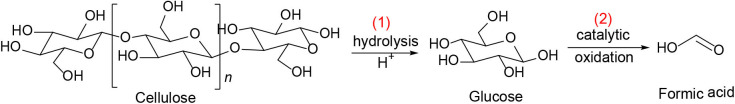
The stages of converting cellulose into formic acid.